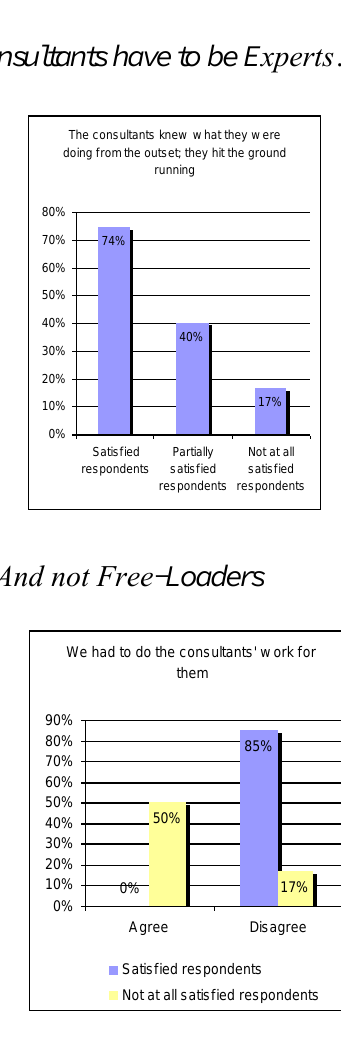
Figure 2 : Consultants have to be Experts…